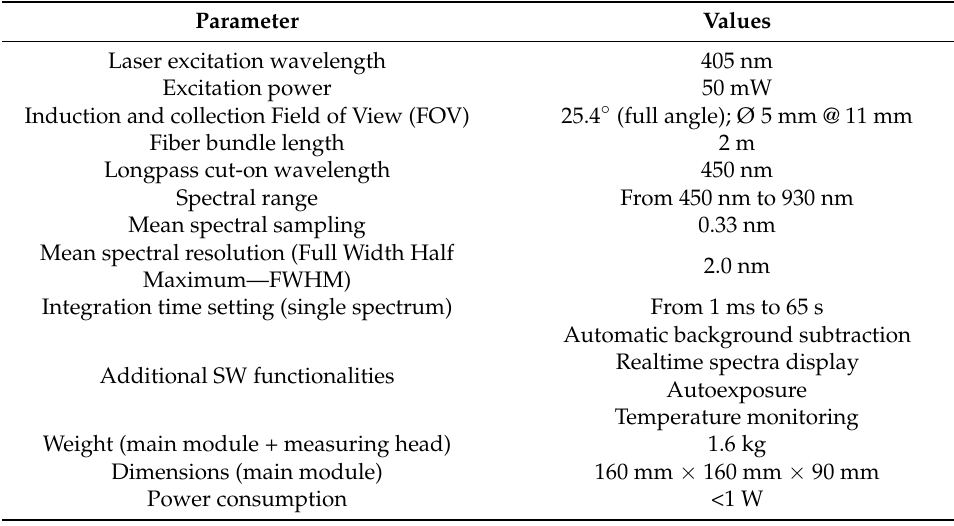
Table 1. SFIDA–405 main technical